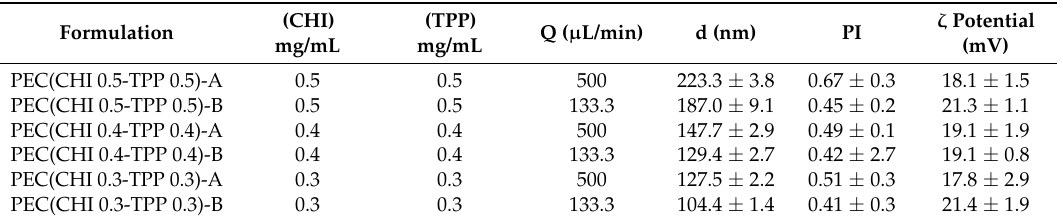
Table 2. Size, PI, and ζ potential values of different PEC formulations. All results are expressed as mean ± SD of at least three independent